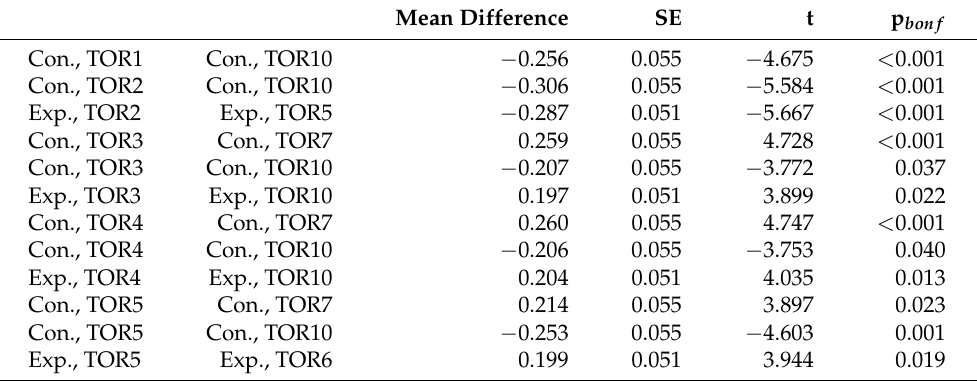
Table A2. Bonferroni post-hoc comparisons on vehicle jerk—the interaction Group ∗